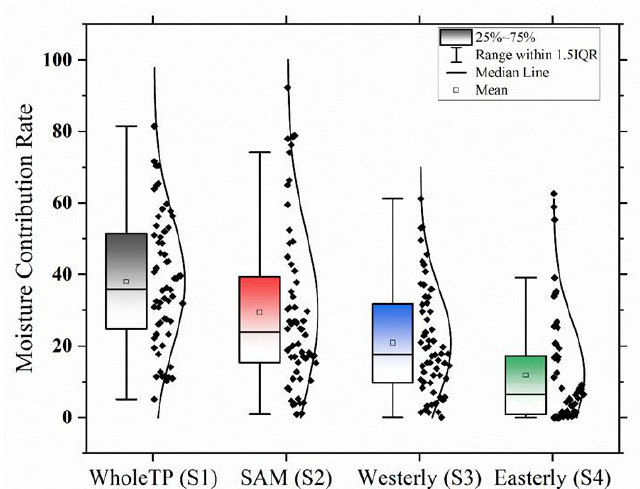
Figure 5. Boxplot from raw data (black dots) of moisture contribution ratios of the four source regions during all the 60 extreme precipitation events in the Northern Tibetan Plateau. Note: The curve right to the boxplot is a normal distribution curve from raw data of moisture contribution ratio.